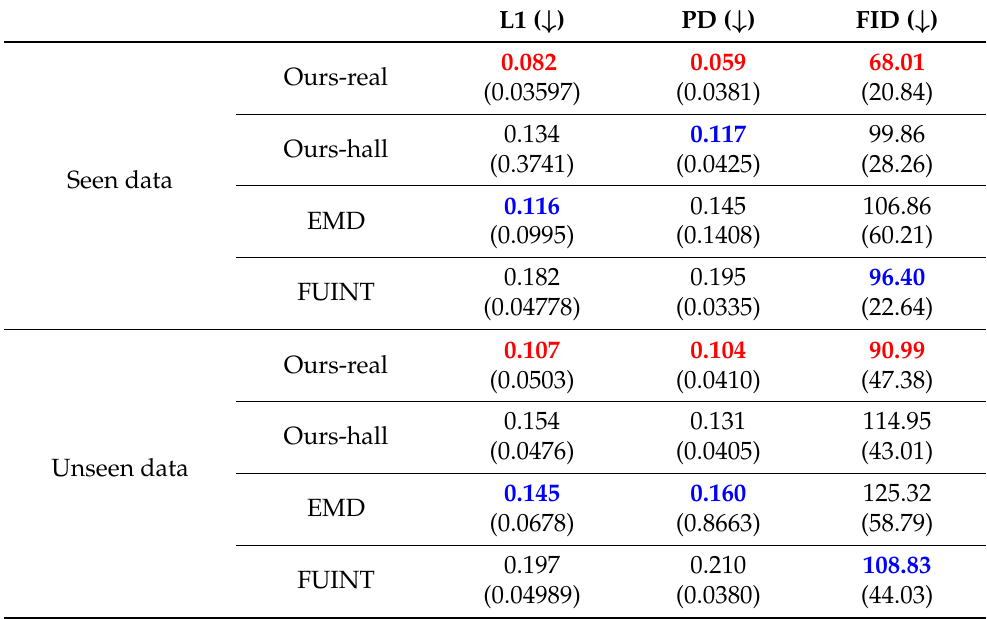
Table 5. Quantitative performance comparison. All values are the average (standard deviation) of 302 calculations of each measurement and less is better. The red and blue values represent the best and second best performance